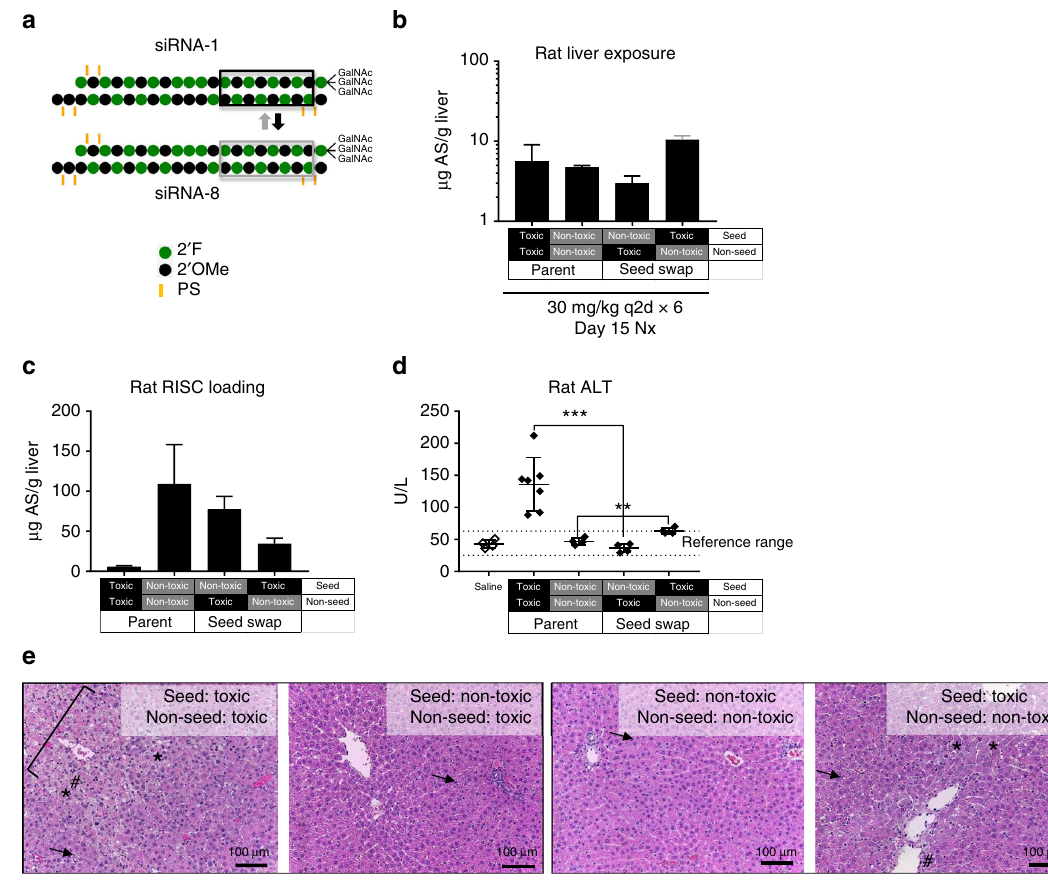
Fig. 4 Swapping seed regions mitigates hepatotoxicity. a Chemical structures of seed swapping between a hepatotoxic and a non-hepatotoxic GalNAc- siRNA. b Liver exposures for parent and seed-swapped GalNAc-siRNAs in rat toxicity study as assessed by stem-loop RT-qPCR for the antisense strand (AS) at necropsy (nx). c Liver RISC loading as assessed by stem-loop RT-qPCR for the antisense strand at necropsy. d Serum alanine aminotransferase (ALT) levels measured at necropsy. Differences between group means were evaluated for statistical signi fi cance using one way ANOVA with post hoc corrections (for multiple siRNAs) in GraphPad Prism 7. ns, not signi fi cant; ** p < 0.01, *** p < 0.001. Error bars represent standard deviation of the mean. e H&E staining of liver sections collected at necropsy. The toxic siRNA had hepatocellular degeneration (bracket), single cell necrosis (*),